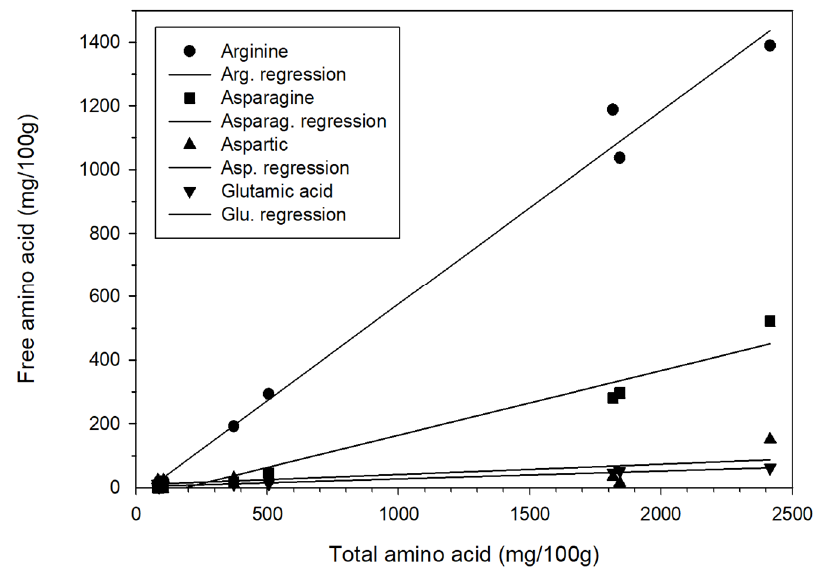
Figure 2. Correlation between free amino acid and total amino acid content.